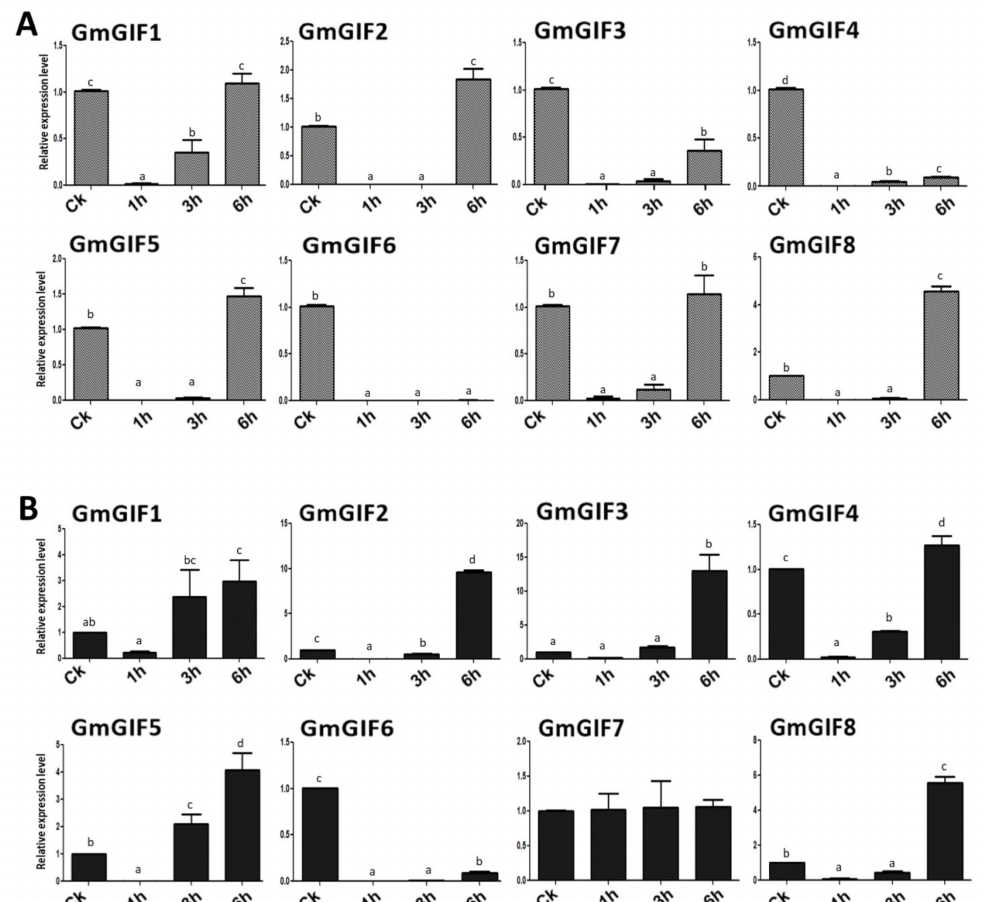
Figure 6. Relative expression patterns of GmGIFs genes under Cd and Cu treatment by RT − qPCR ( A , B ). The x -axis represents the time points, and the y -axis represents the relative expression scale. Tukey’s tests were used to examine differences between effects on different time hours under various treatments, and different letters show a significant difference ( p <